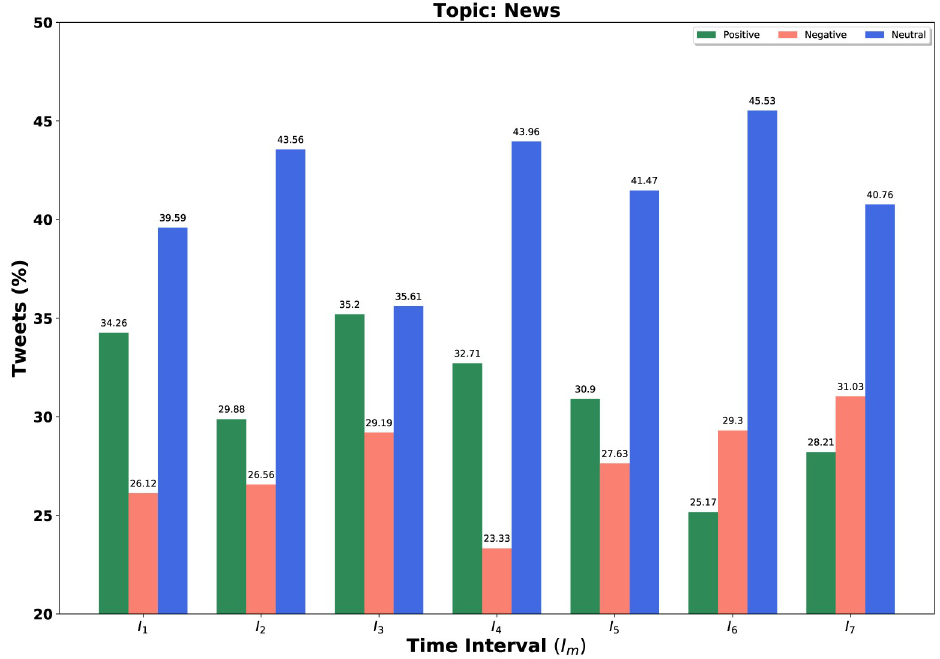
Fig 4. Overall sentiment dynamics on Twitter at different time intervals I